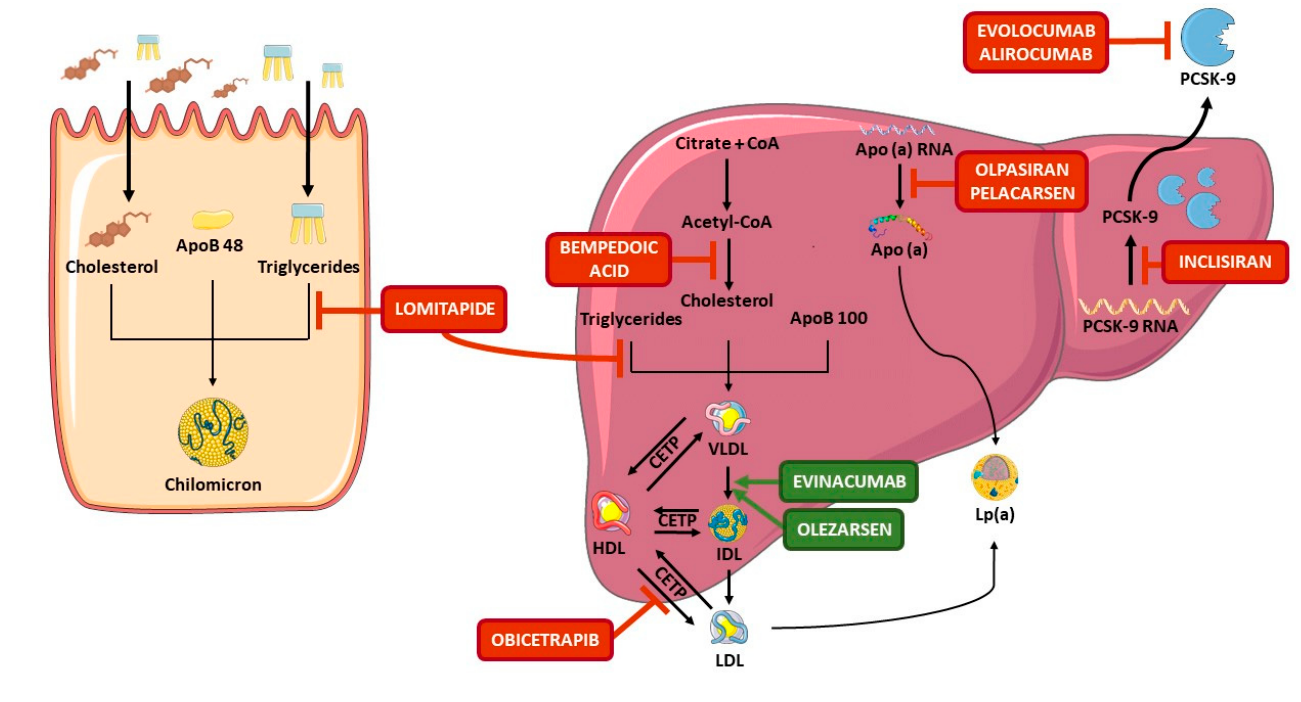
Figure 1. Mechanisms of action of emerging lipid-modifying drugs. BA reduces cholesterol synthesis in cells by inhibiting ATP-citrate lyase. BA is a prodrug activated by ACSVL1, which is selectively expressed in hepatocytes. Activated BA, similarly to statins, upregulate the expression of the LDLR to compensate for reduced intracellular cholesterol. Evolocumab and alirocumab neutralize circulating PCSK-9, whereas inclisiran binds to PCSK9 mRNA, mainly in liver cells, inducing its degradation and, thus, the synthesis of PCSK-9. In both cases, loss of PCSK-9 function reduces the degradation of LDLR, increasing their expression in cell membranes. Lomitapide inhibits MTP, which reduces the assembly between lipids and apoB in hepatocytes and enterocytes and, thus, the production and secretion of VLDL and chylomicrons. Evinacumab neutralizes circulating ANGPTL3, thus reducing its inhibitory effect on LPL and EL, leading to an increased lipolysis of VLDL and clearance of IDL, upstream of LDL formation, by a putative hepatic IDL-receptor. Obicetrapib inhibits CETP, which mediates the transfer of cholesteryl esters from HDL to the APOB-containing VLDL-IDL-LDL, markedly raising HDL-C and lowering cholesterol contained in atherogenic particles. Olezarsen reduces APOC3 production by liver cells by inhibiting APOC3 mRNA transcription. Reduction in APOC3 function releases LPL from its inhibitory effect, enhancing the lipolytic cascade. Pelarcansen promotes the degradation of APO(a) mRNA in liver cells while Olpasiran blocks the translation of APO(a) mRNA in liver cells, leading, in both cases, to a reduced synthesis and secretion of lipoprotein(a).